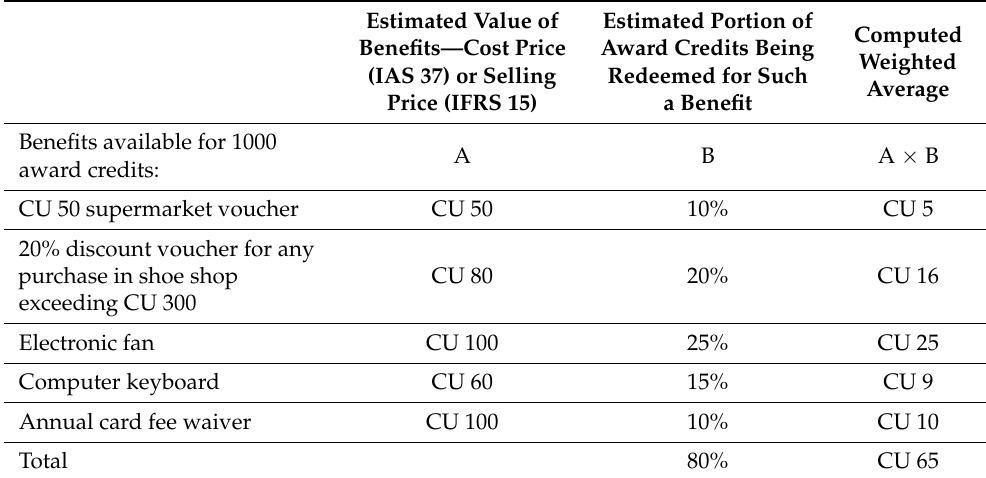
Table 1. Estimating the value of award credits (Source: Adapted from KPMG